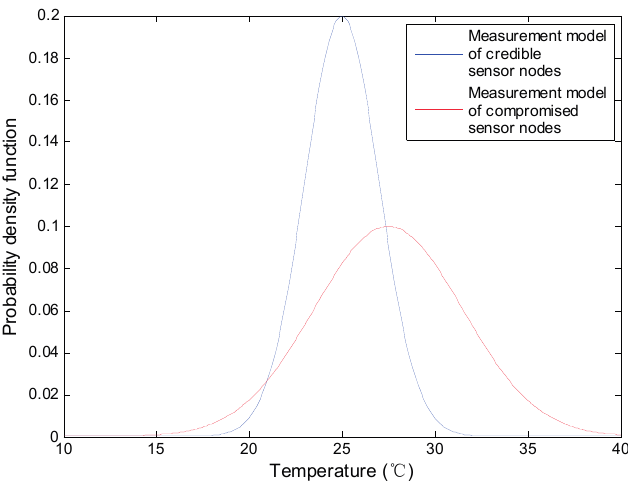
Figure 11. Measurement models of sensor